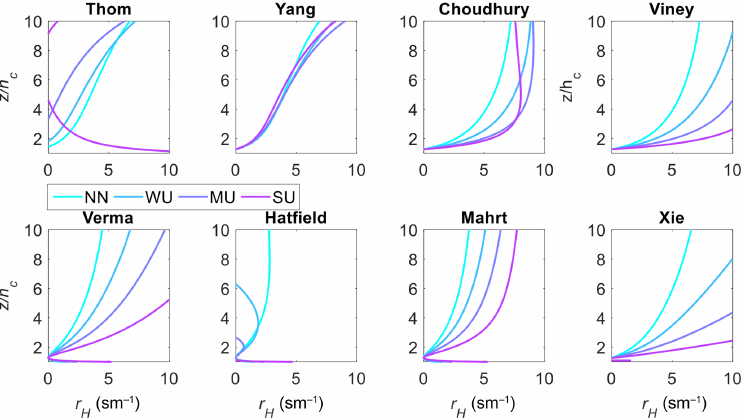
Figure 4. Variations of r H with height for different stability classes computed for each parameterization scheme as described in Table 1.